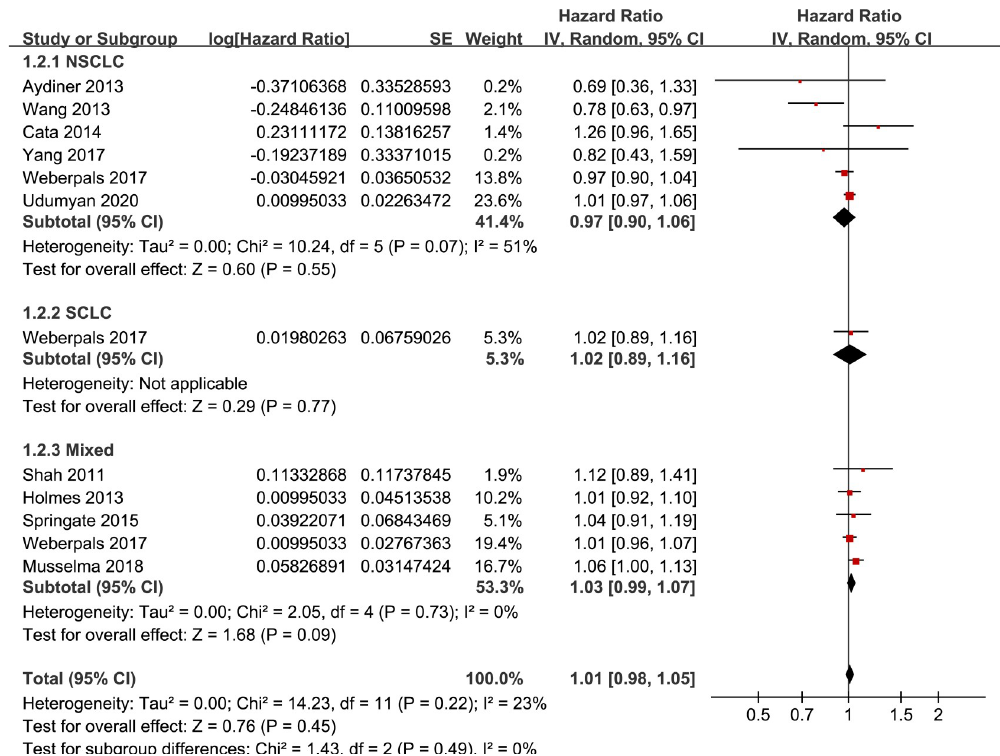
Fig 3. Stratified analyses for the meta-analysis of the association between BB use and OS of lung cancer according to the category of lung cancer.